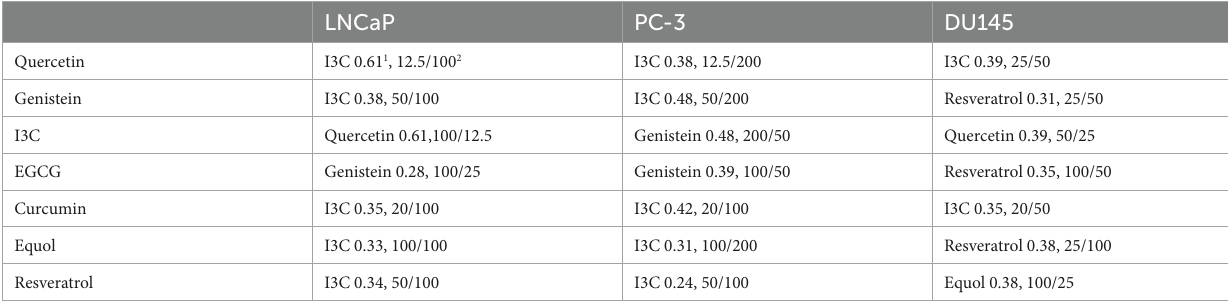
TABLE 1 Phytochemical combinations with maximum synergy in each cell